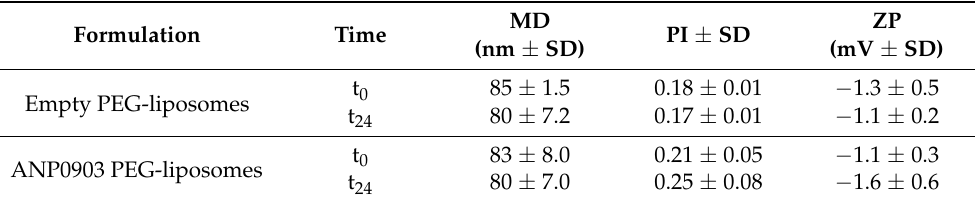
Table 2. Mean diameter (MD), polydispersity index (PI), and zeta potential (ZP) of PEG-liposomes diluted and incubated with a simulated body fluid (Hank’s solution, pH 7.4) for 24 h, at 37 ◦ C. The measurements were carried out immediately after the dilution (t 0 ) and after 24 h (t 24 ) of incubation. Mean values ± SD are reported ( n = 6). ZP MD PI ± SD Formulation Time (mV ± SD) (nm ± SD) t 0 85 ± 1.5 0.18 ± 0.01 − 1.3 ± 0.5 Empty PEG-liposomes t 24 80 ± 7.2 0.17 ± 0.01 − 1.1 ± 0.2 t 0 83 ± 8.0 0.21 ± 0.05 − 1.1 ± 0.3 ANP0903 PEG-liposomes t 24 80 ± 7.0 0.25 ± 0.08 − 1.6 ± 0.6